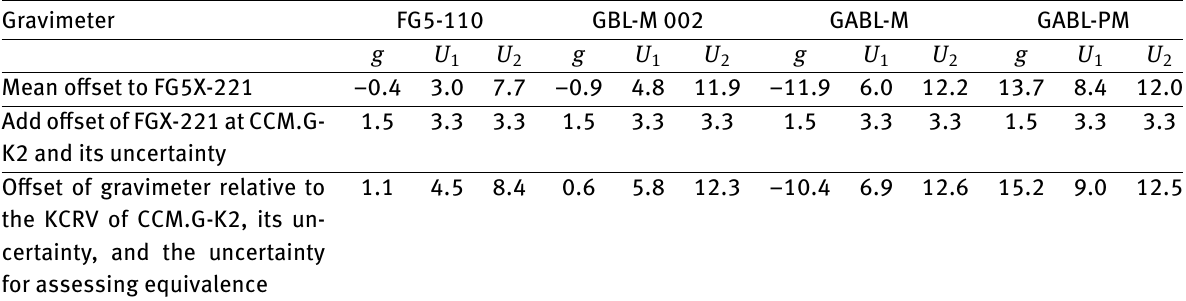
Table 7: Final results of the RFCAG2013. The top row is from Table 6 and contains in column “g” the mean offset of the AG relative to the FG5X-221 at the 2–6 stations, in column “ U ” the uncertainty of the offset, and in column “ U 1 second row we then add in the column “ g ” the offset of the FG5X-221 at CCM.G-K2 and in columns “ U the bottom row we then obtain the offset of the AG relative to the KCRV of the CCM.G-K2 (in column “ g ”), its uncertainty (in column “ U and the uncertainty (in column “ U ”) for assessing the Degree of Equivalence. All units are microgals and all uncertainties are expanded 2 uncertainties (95% confidence). More comments in